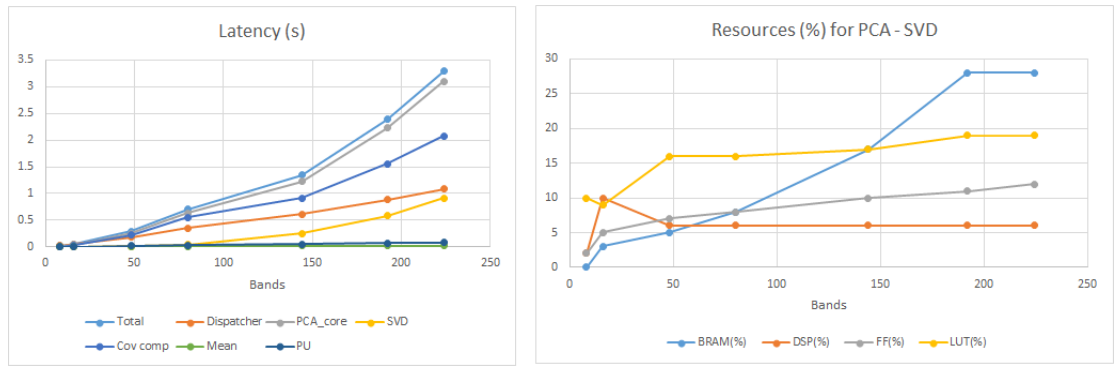
Figure 11. Latency and resource usage for Virtex7 with a fixed block size ( B max = 8), floating-point